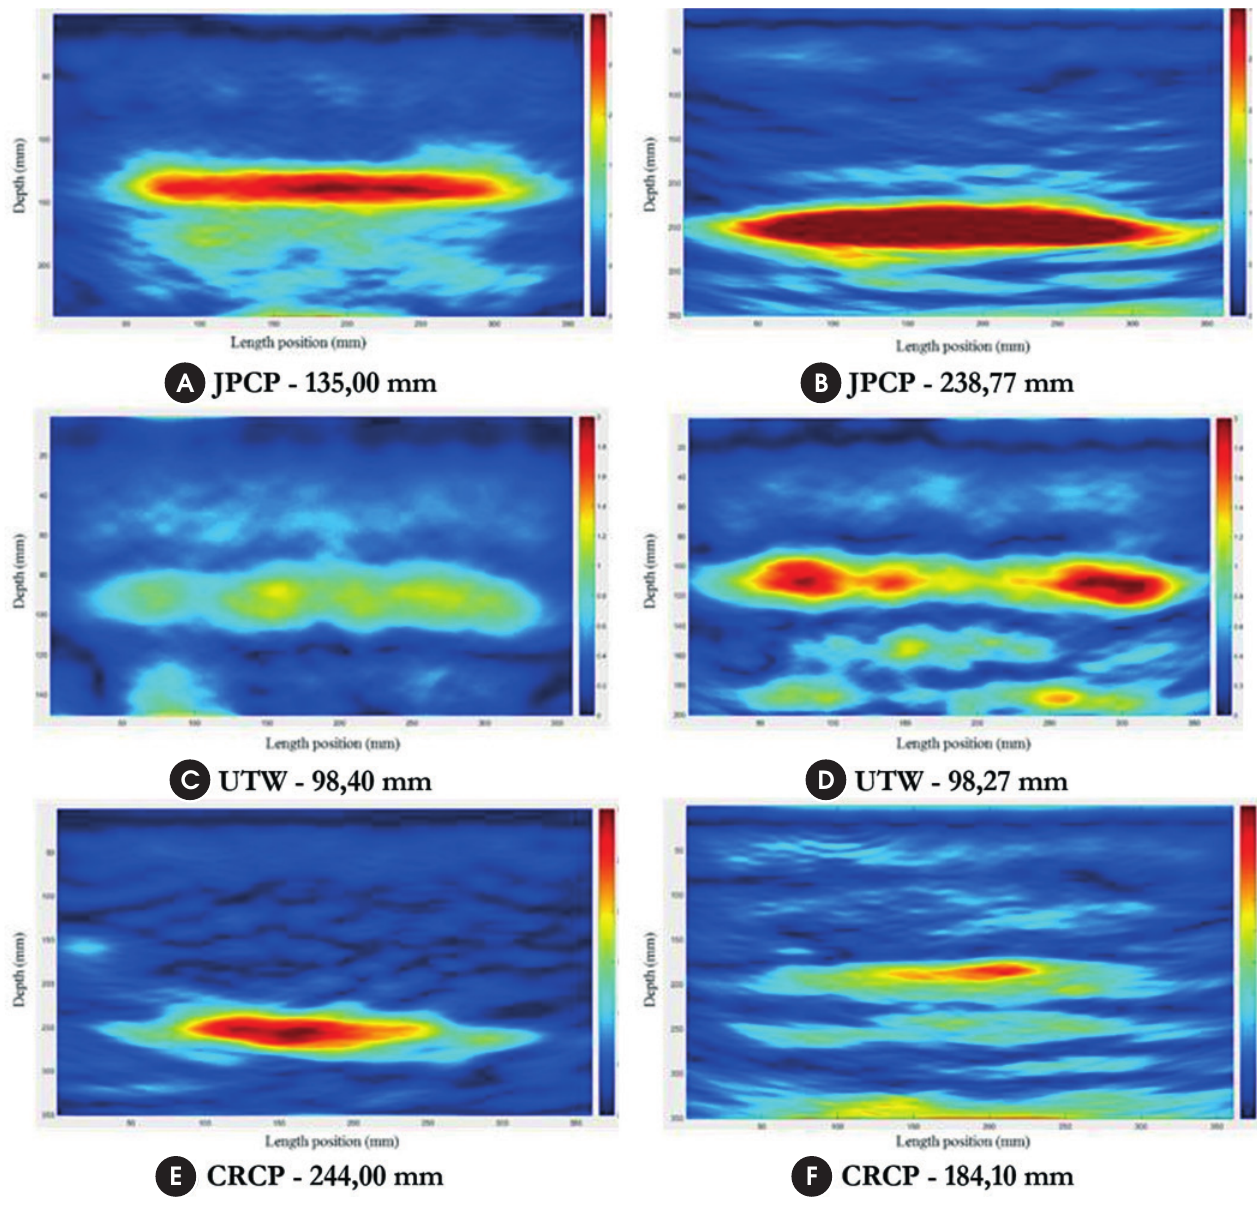
Figure 3 Thickness surveys reconstructions in concrete slabs with designed thickness of (a) 150 mm; (b) 250 mm; (c) and (d) 100 mm; and (e) and (f) 240